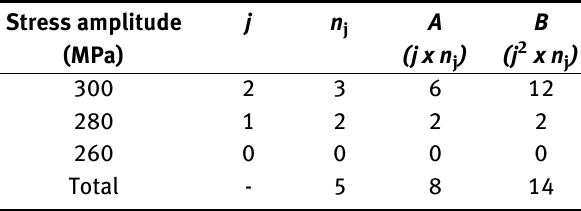
Table 2: Parameters of j and n j by Dixon and Mood approach. Stress amplitude